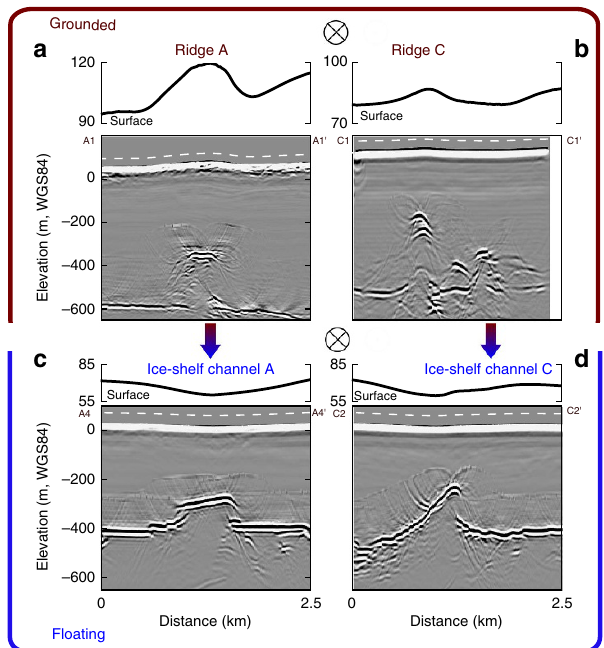
Figure 6 | Surface ridges landwards of ice-shelf channels. ( a , b ) Migrated radargrams, aligned across-flow, showing the reflectors A and C located on grounded ice. The reflectors turn into ice-shelf channels ( c , d ) incising the floating ice shelf. The top panels display the surface topography in which the grounded sections both show prominent surface ridges aligned with the respective reflector locations. In the floating ice-shelf channels, the ridges are mostly absent, and the surfaces are depressed. The white dashed curve in the radargrams marks the surface.